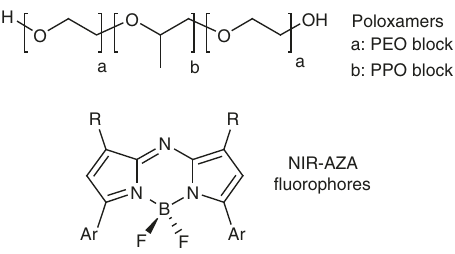
Fig. 1 Component classes selected for directed self-assembly. General structures of poloxamer tri-block co-polymers and BF 2